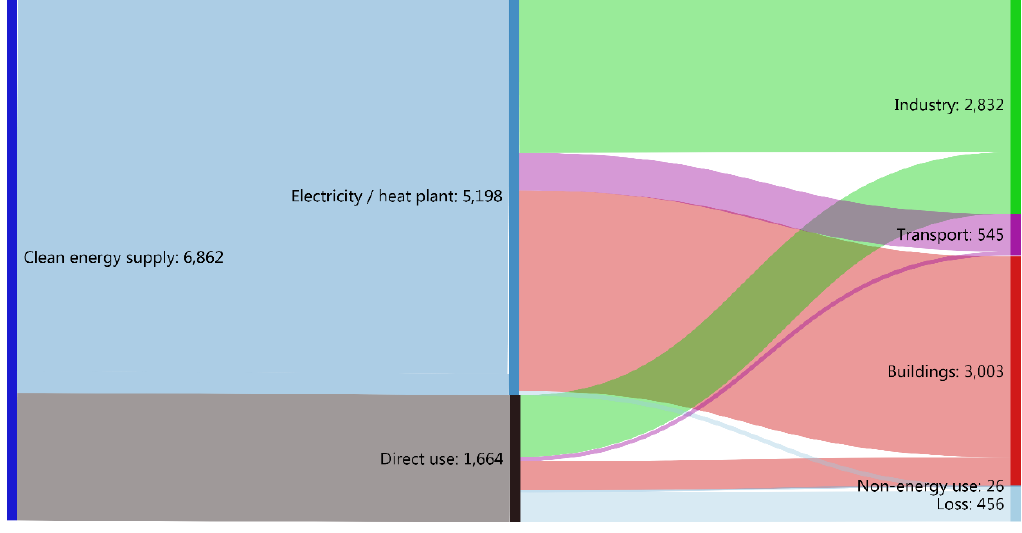
Figure 12. Clean Energy Consumption Flow in 2050 (Unit: 100 Mtoe).